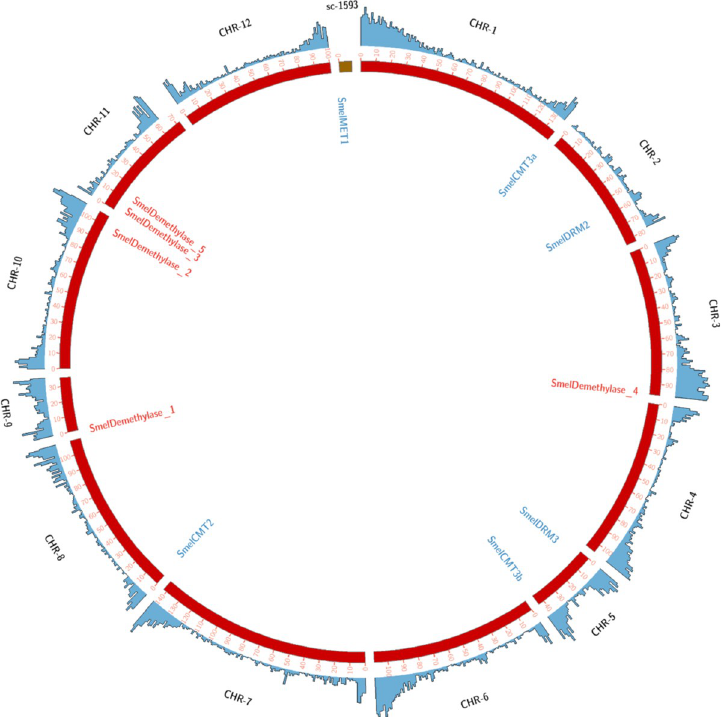
Fig 2. Chromosomal location of genes encoding C5-MTase and demethylase. The 12 pseudomolecules (chromosomes) are depicted by the set of red bars in the center, and gene density (1 Mbp windows) by the outer blue track. Location of each gene is showed.